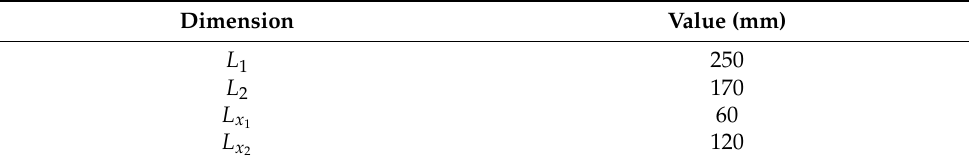
Table 4. Geometrical parameters of a magnetic spring as an energy-storing system for a two DoF humanoid arm.